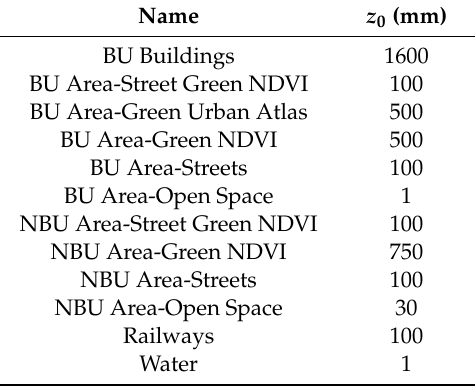
Table 3. Roughness length ( z 0 ) assigned to the European Settlement Map (ESM) 2012 R 2017 [37] land use classes with acronyms for non-built up (NBU), built up (BU) and Normalized Di ff erence Vegetation Index